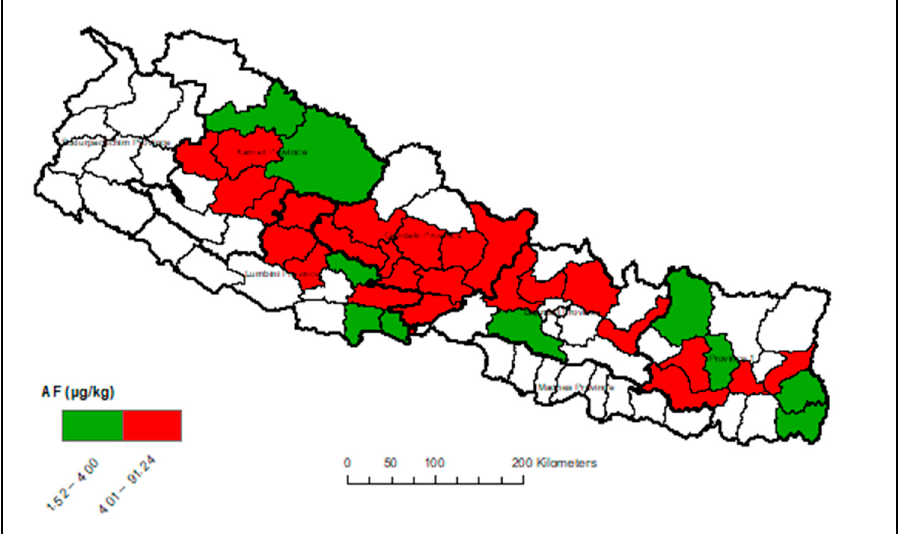
Figure A5. Heat map of AF occurrence in Nepalese maize. The range of found concentration of AF is shown in green and red colors, where red indicates the areas exceeding the EU maximum limit. AF was found in concentrations of 1.52 of 91.24 µg/kg.